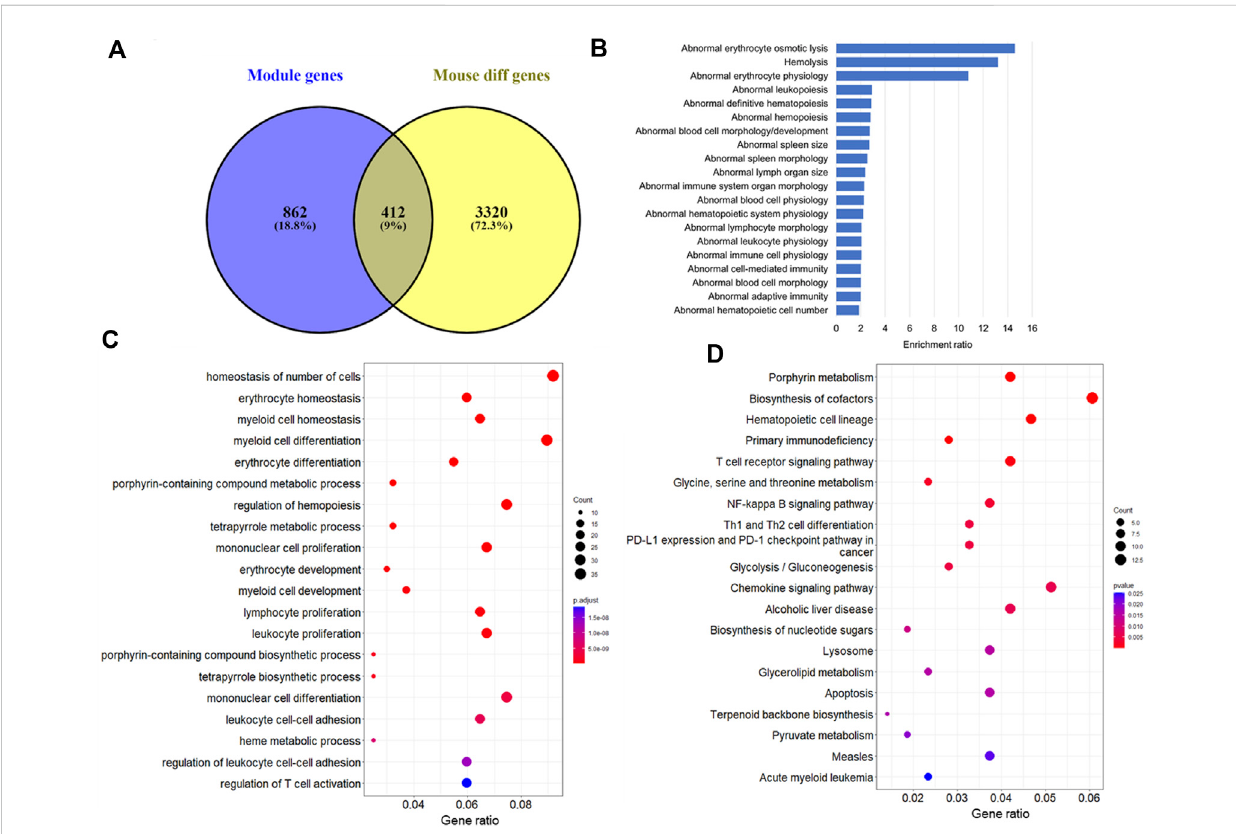
FIGURE 2 Functional analysis of the module genes that were differentially expressed between AML and healthy mice. (A) Number of mice orthologs that were part of signi fi cant co-expression modules as well as differentially expressed between AML and healthy mouse (a total of 412 genes were found common between both the lists). Top 20 (B) Mammalian Phenotype Ontologies, (C) Gene Ontology biological processes, and (D) KEGG pathways signi fi cantly enriched by the 412